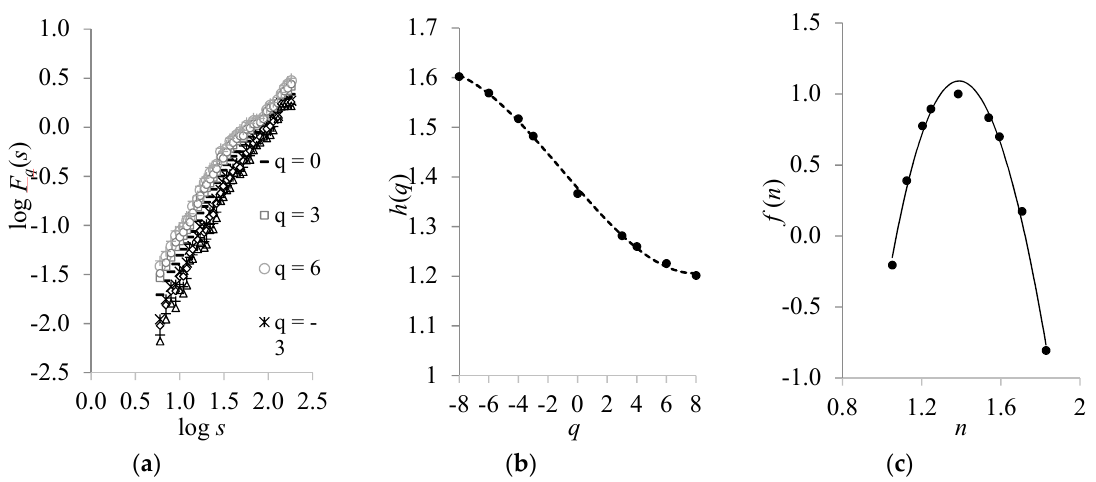
Figure 5. As in Figure 3, but for the detrended and deseasonalized CST time-series. ( a ) In ( b ), the empirical curve (dots) was fitted by the polynomial h(q) = 1·10 − 4 q 3 + 4·10 − 4 q 2 − 0.03 q + 1.38, with R ² = 1.00. In ( c ), the empirical curve (dots) was fitted with f(n) = 1.61 n 3 − 17.06 n 2 + 38.06 n − 23.18, with R ² = 0.99.